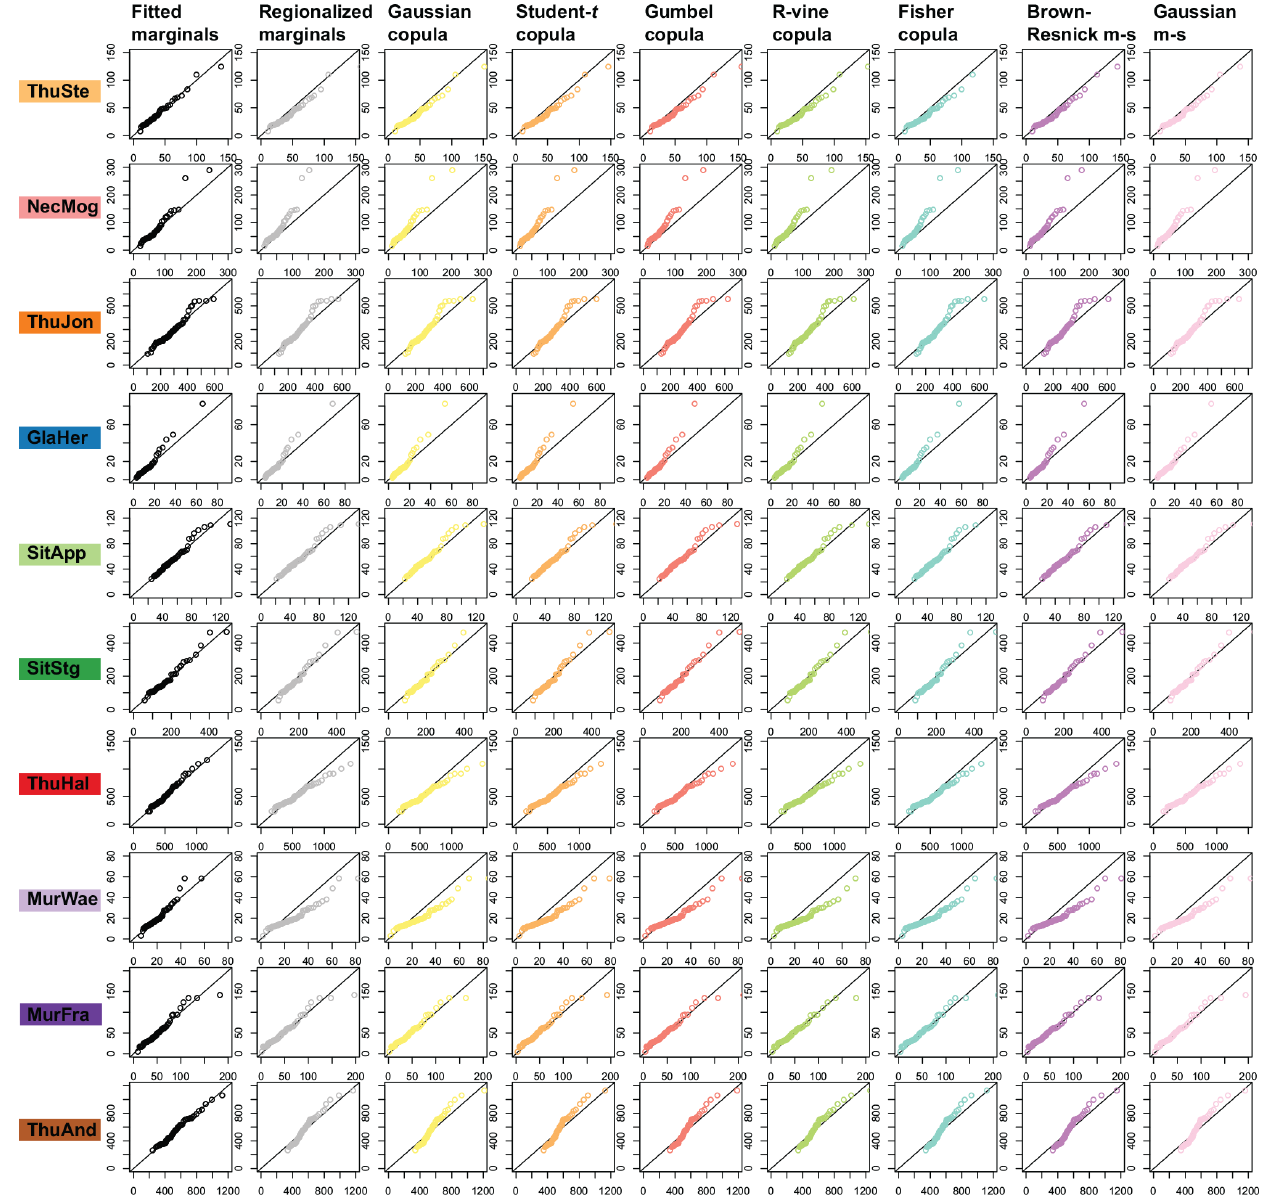
Figure 6. The first two columns show QQ plots obtained by the fitted GEV parameters (fitted marginals) and by the regionalized GEV parameters (regionalized marginals) for the 10 study stations. The following columns show QQ plots of samples simulated using different models and back-transformed using the regionalized GEV